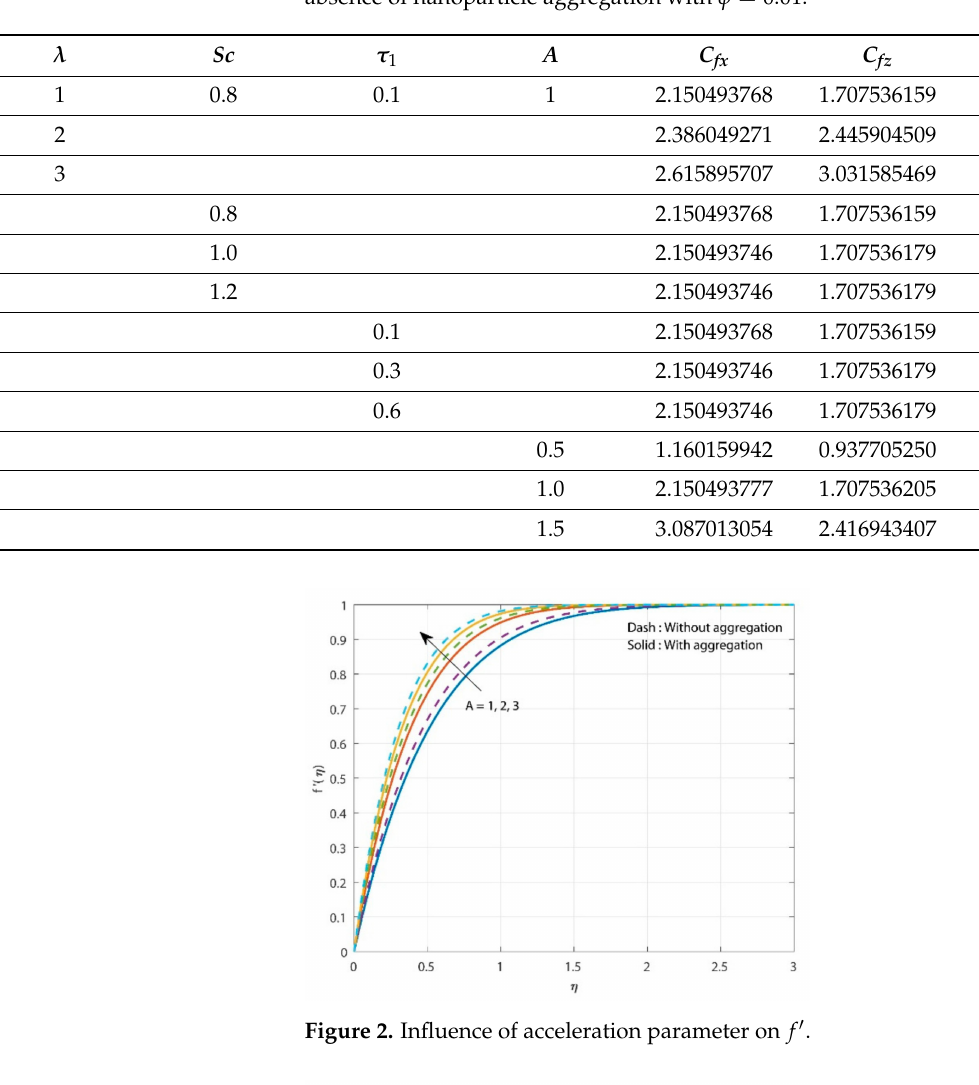
Table 9. Computational values of C fx , C fz , Nu and Sh for various dimensionless constraints in the absence of nanoparticle aggregation with φ = 0.01.